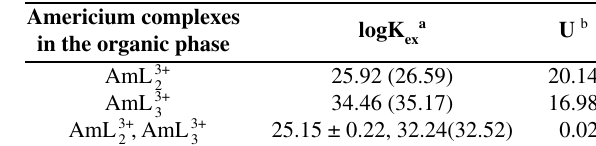
Table 4. Comparison of various models of americium extraction from aqueous solution of HNO by nitrobenzene solution of H + B 3